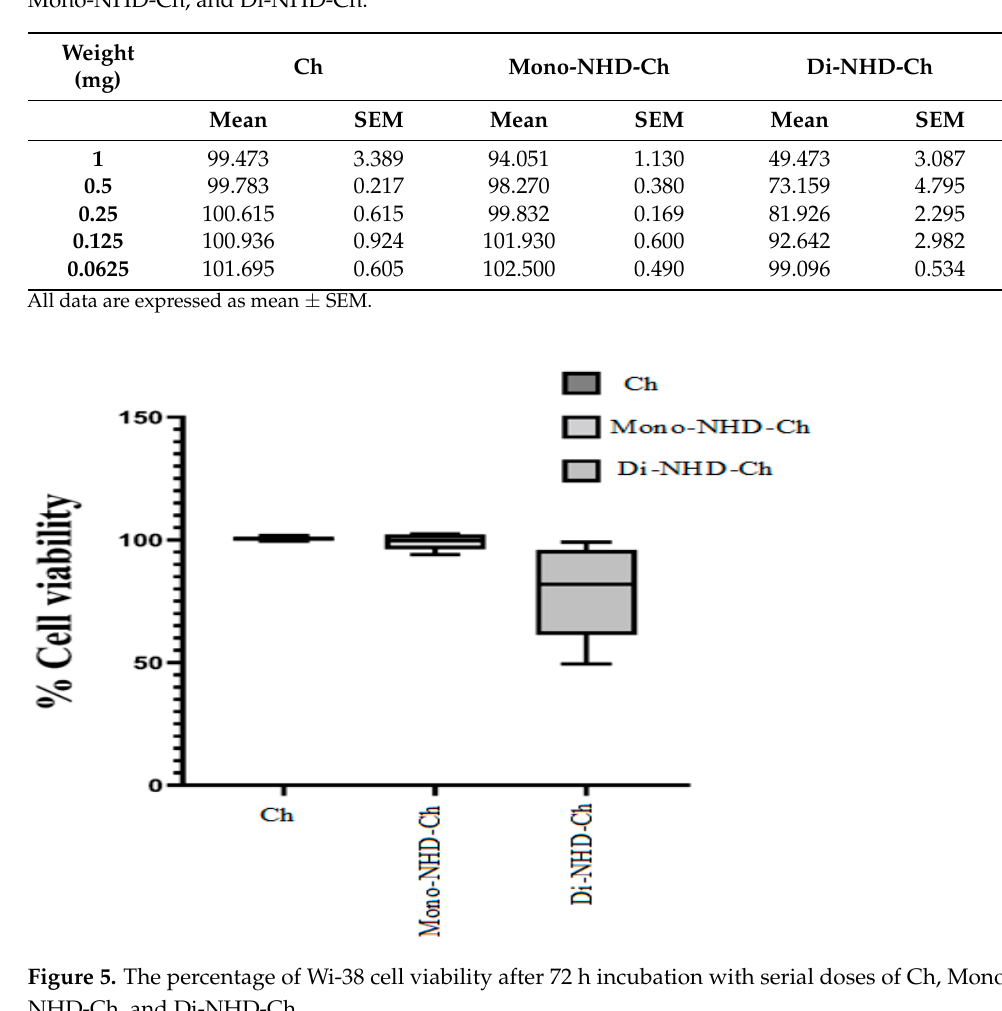
Table 4. The percentage of Wi-38 cell viability after 72 h of incubation with serial doses of Ch, Mono-NHD-Ch, and Di-NHD-Ch.